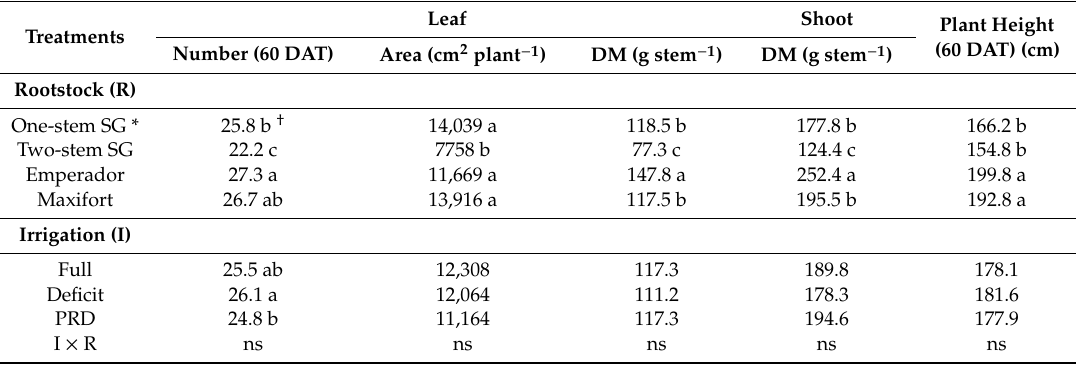
Table 2. E ff ect of rootstock type and irrigation treatment on tomato vegetative characteristics in the second year of the experiment with plants grown on one and two